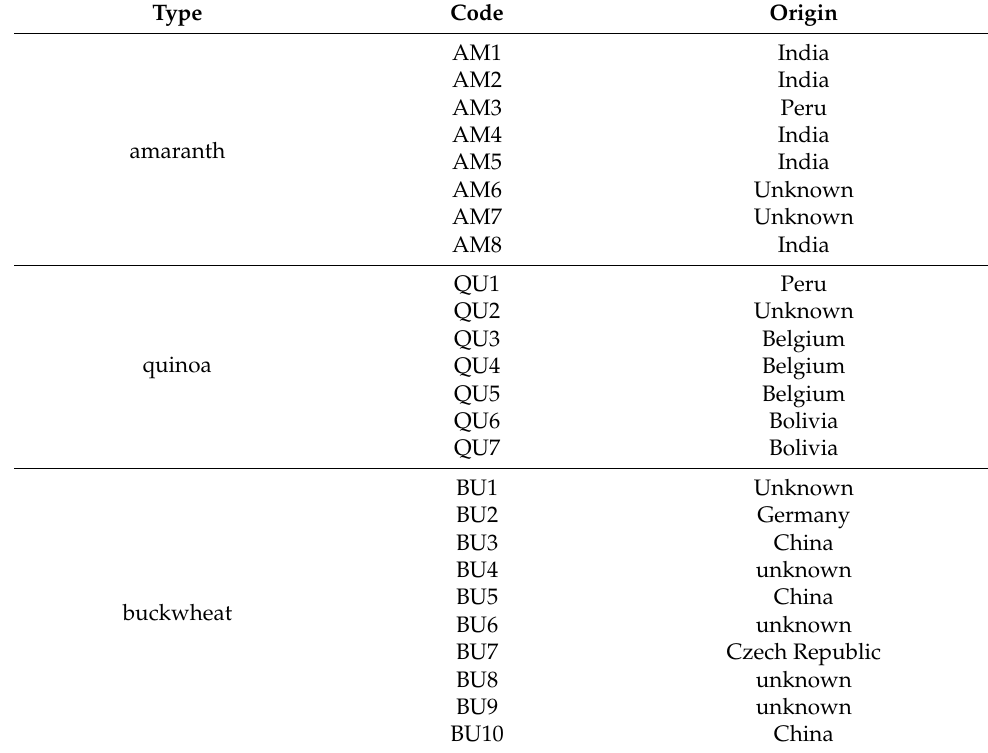
Table 1. Overview of amaranth, quinoa and buckwheat